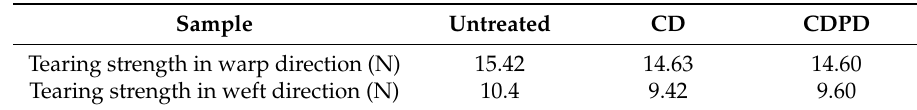
Table 4. Tearing strength of the untreated cotton fabric and cotton fabric finished with pad-dry-plasma-cure (CDPD) and pad-dry-cure (CD) processes both in the warp and weft